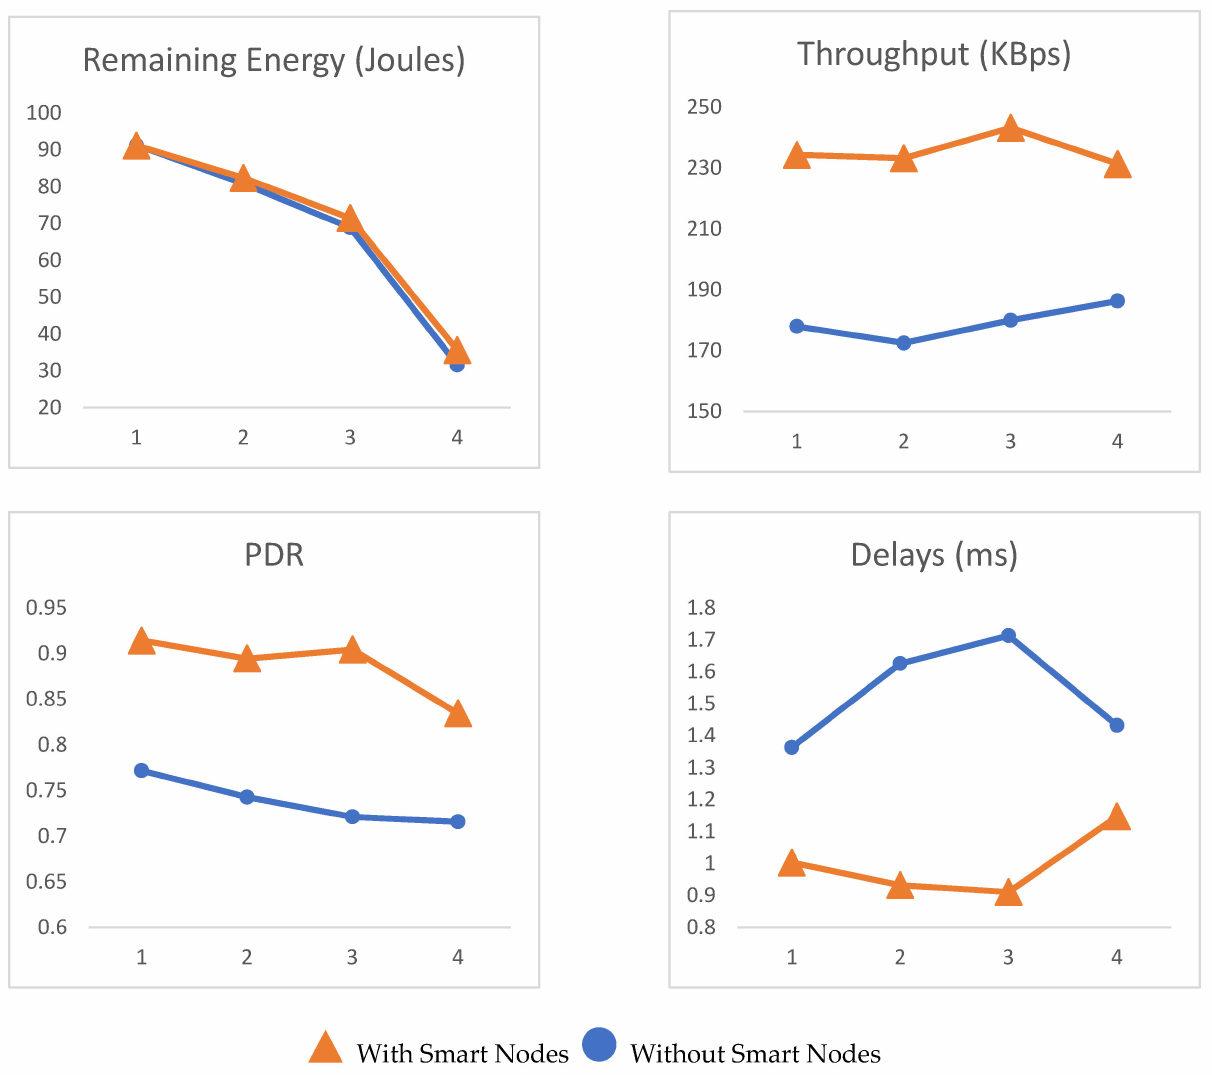
Figure 12. Case scenario 2: Random placement of heterogeneous